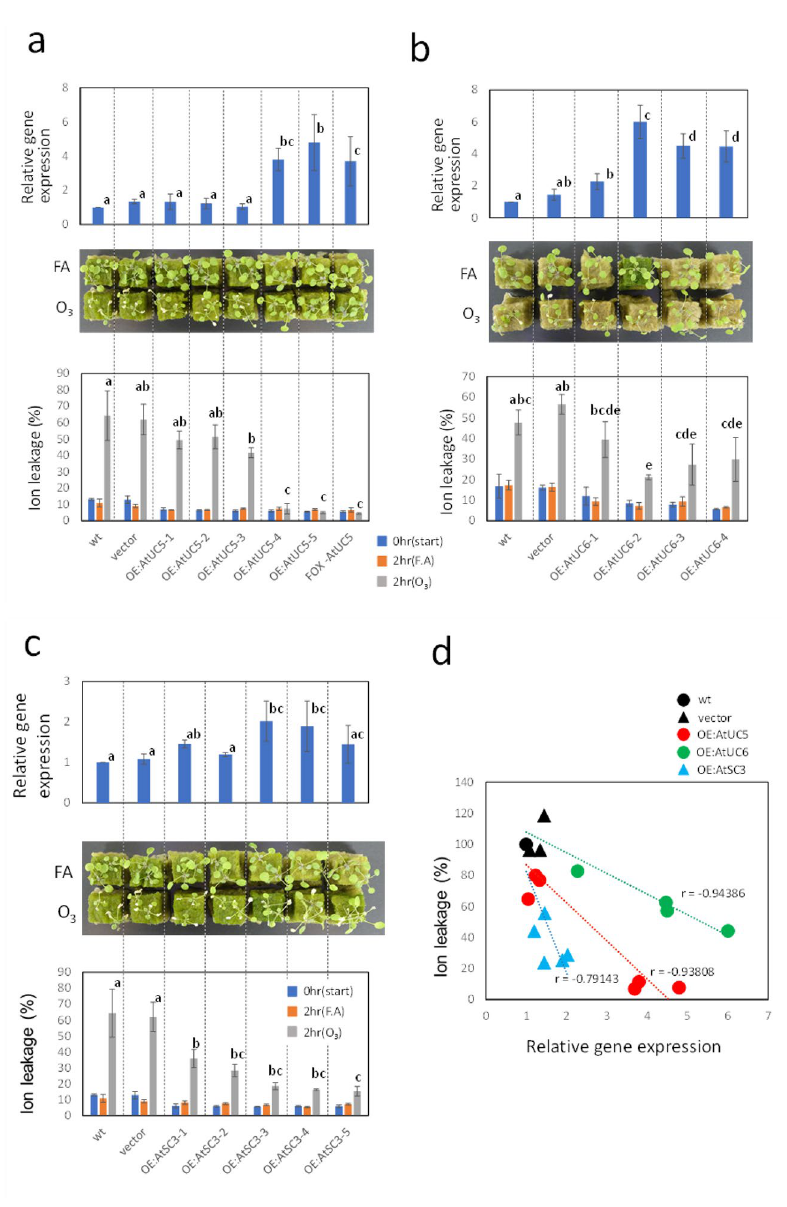
Figure 5. Correlations between transgene expression level and O 3 tolerance observed in various Arabidopsis lines overexpressing different phytocyanin genes. ( a – c ) The levels of mRNA encoding AtUC5 ( a ), AtUC6 ( b ), and AtSC3 ( c ) extracted from 2-week-old seedlings of each transgenic line were measured using reverse transcription PCR and relative values against the control plants (wt) are shown in the upper figure. Images of various plant lines 1 day after 2 h exposure to fresh air or 0.3 µL L −1 O 3 under 420 µmol photons m −2 s −1 illumination are shown in the middle figure. The amounts of ion leakage from the leaves of plants that received either 0 or 2 h fresh air or 0.3 µL L −1 O 3 under an irradiation at 420 µmol photons m −2 s −1 are shown in the bottom figure. Line names shown in the bottom figure also represent those of the upper and middle figures just above the bottom results. For the upper and bottom results, the mean and SD are shown ( n = 3–16) and means with the same letter are not significantly different from each other at p < 0.05. FA fresh air, wt wild type, vector a plant to which only vector was introduced, OE:AtUC5-1(or 2, 3, 4, 5) AtUC5 -overexpressing lines, OE:AtUC6- 1(or 2, 3, 4) AtUC6- overexpressing lines; AtSC3-1 (or 2, 3, 4, 5), AtSC3 -overexpressing lines. ( d ) Correlations between levels of transgene expression and ion leakage from leaves treated with ozone for 2 h, in various transgenic lines. The correlation coefficient (r) of the linear relationship for each transgenic line is shown in the